Question: Provide a one-line summary of what is displayed.
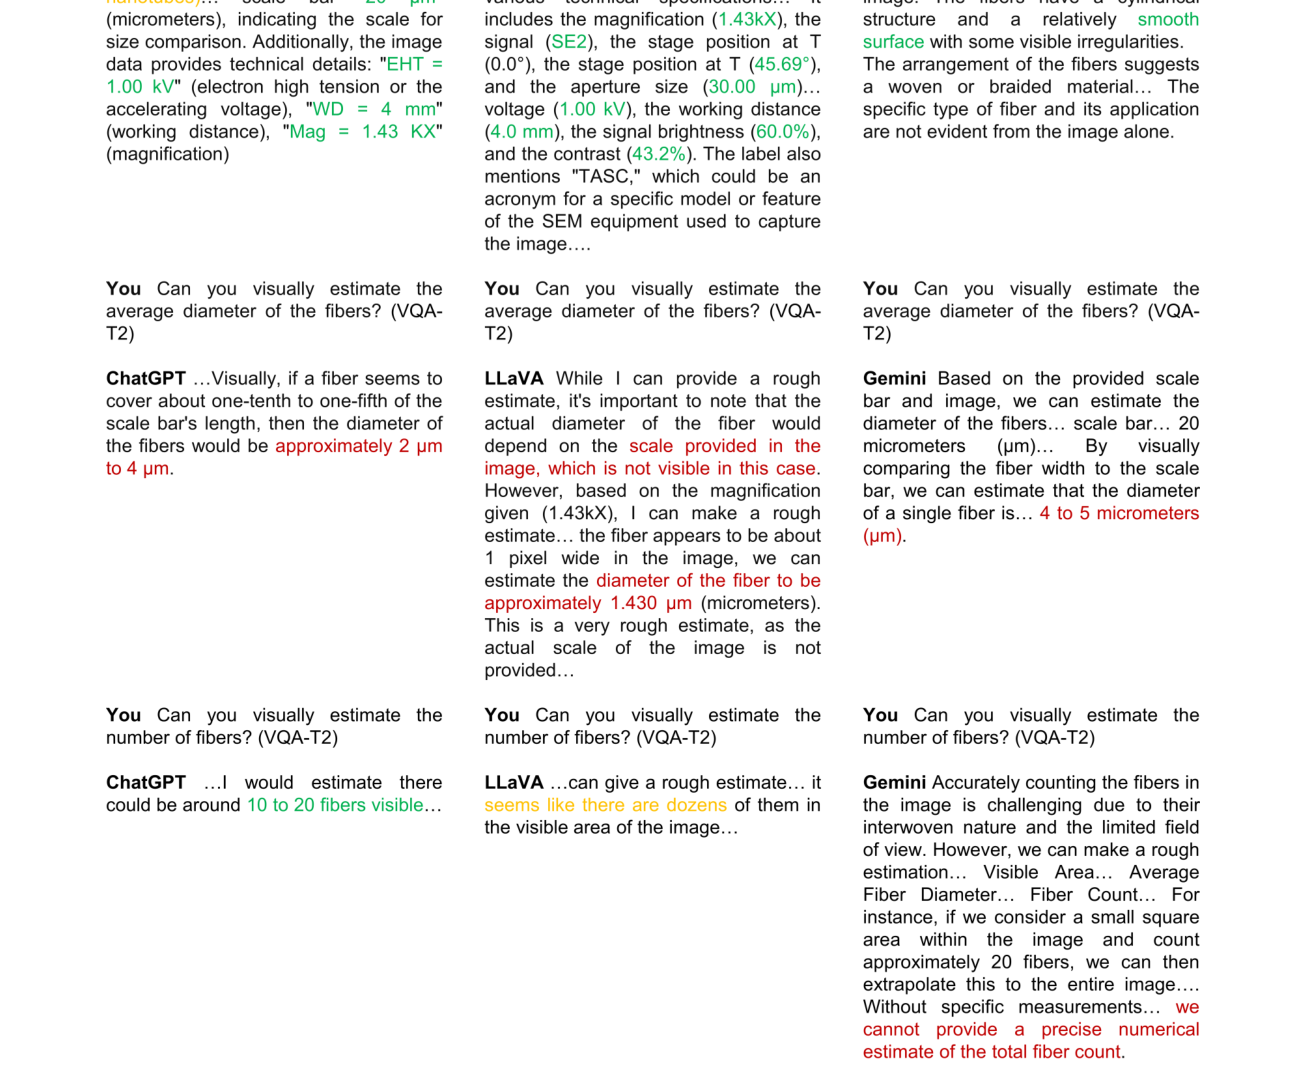
Answer: Performance of ChatGPT, LLaVA, and Gemini (left to right) on VQA tasks of describing an image of fibers and estimating the number and average diameter of fibers. Correct key responses are colored in green, wrong responses in red, and mixed or uncertain in orange. Extraneous information has been replaced with ellipses.